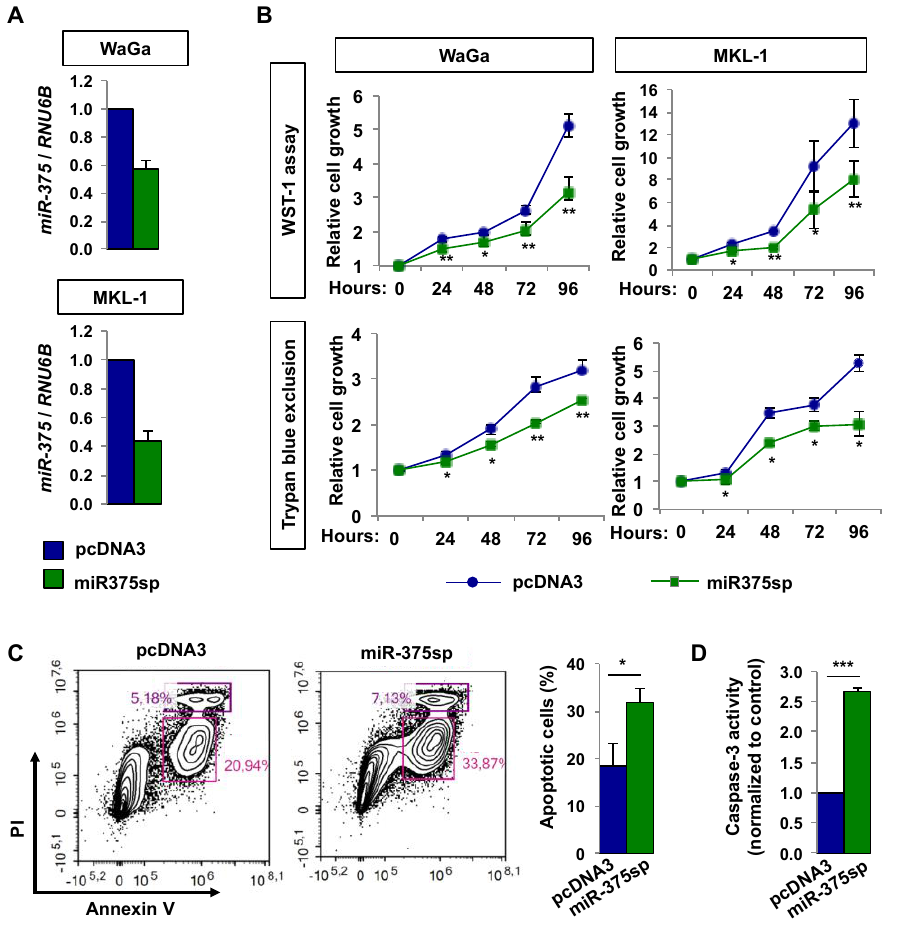
Figure 5. Inhibition of miR-375 reduces cell growth and induces apoptosis in MCPyV+ MCC cell lines. WaGa and MKL-1 cells were transfected with miR-375sp or vector control (pcDNA3) for 72 h. ( A ) RT-qPCR analysis of miR-375 levels in cells transfected with miR-375sp or pcDNA3. The miR-375 expressions were normalized to RNU6B . ( B ) Effect of miR-375 inhibition on cell growth was evaluated at different time points using WST-1 and trypan blue exclusion assays. ( C ) Representative flow cytometric images of WaGa cells co-stained with Annexin V-FITC and propidium iodide (PI) upon inhibition of miR-375 . The apoptotic cells (Annexin V + /PI − ) and the necrotic cells (Annexin V + /PI + ) are represented in the lower and upper boxes, respectively. Quantification of the apoptotic cells is shown on the right panel. ( D ) Caspase-3 activity was quantified in WaGa cell lysates with and without inhibition of miR-375 . Data are means ± SEM of three independent experiments. * p < 0.05, ** p < 0.01, and *** p = 0.001 by paired Student’s t -test. ns = not significant.